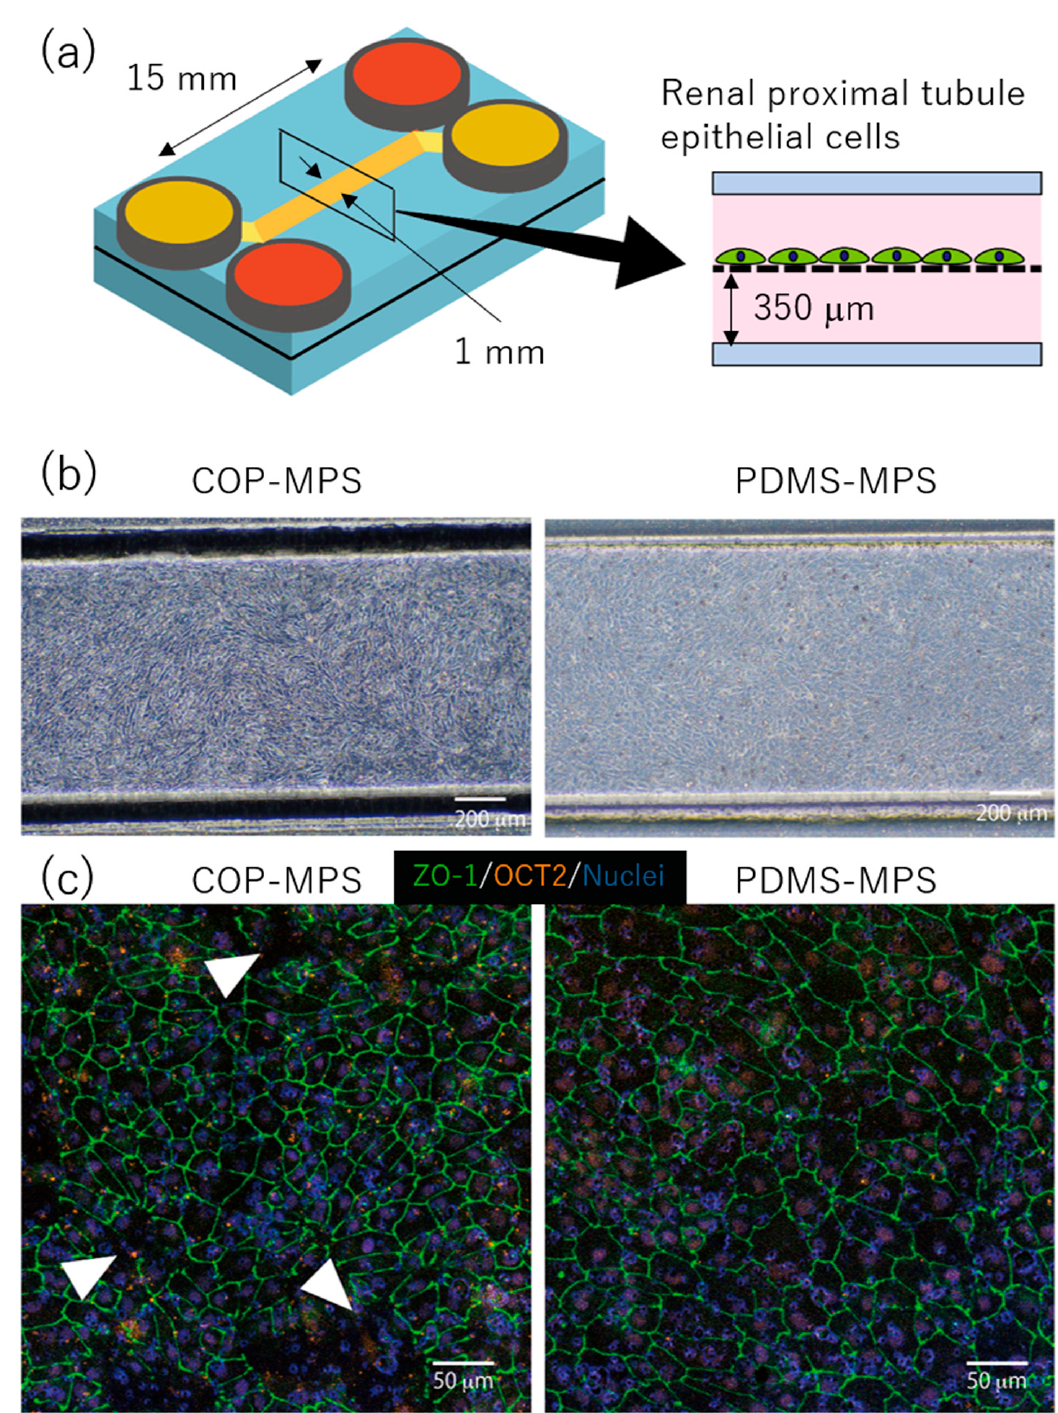
Figure 4. RPTEC cultured in COP-MPS and PDMS-MPS. ( a ) Schematic diagram of MPS structure; ( b ) Phase-contrast images of RPTEC; ( c ) Immunostaining images of ZO-1 (green), OCT-2 (orange), and nuclei (blue). White arrowheads indicate faint signals of ZO-1.